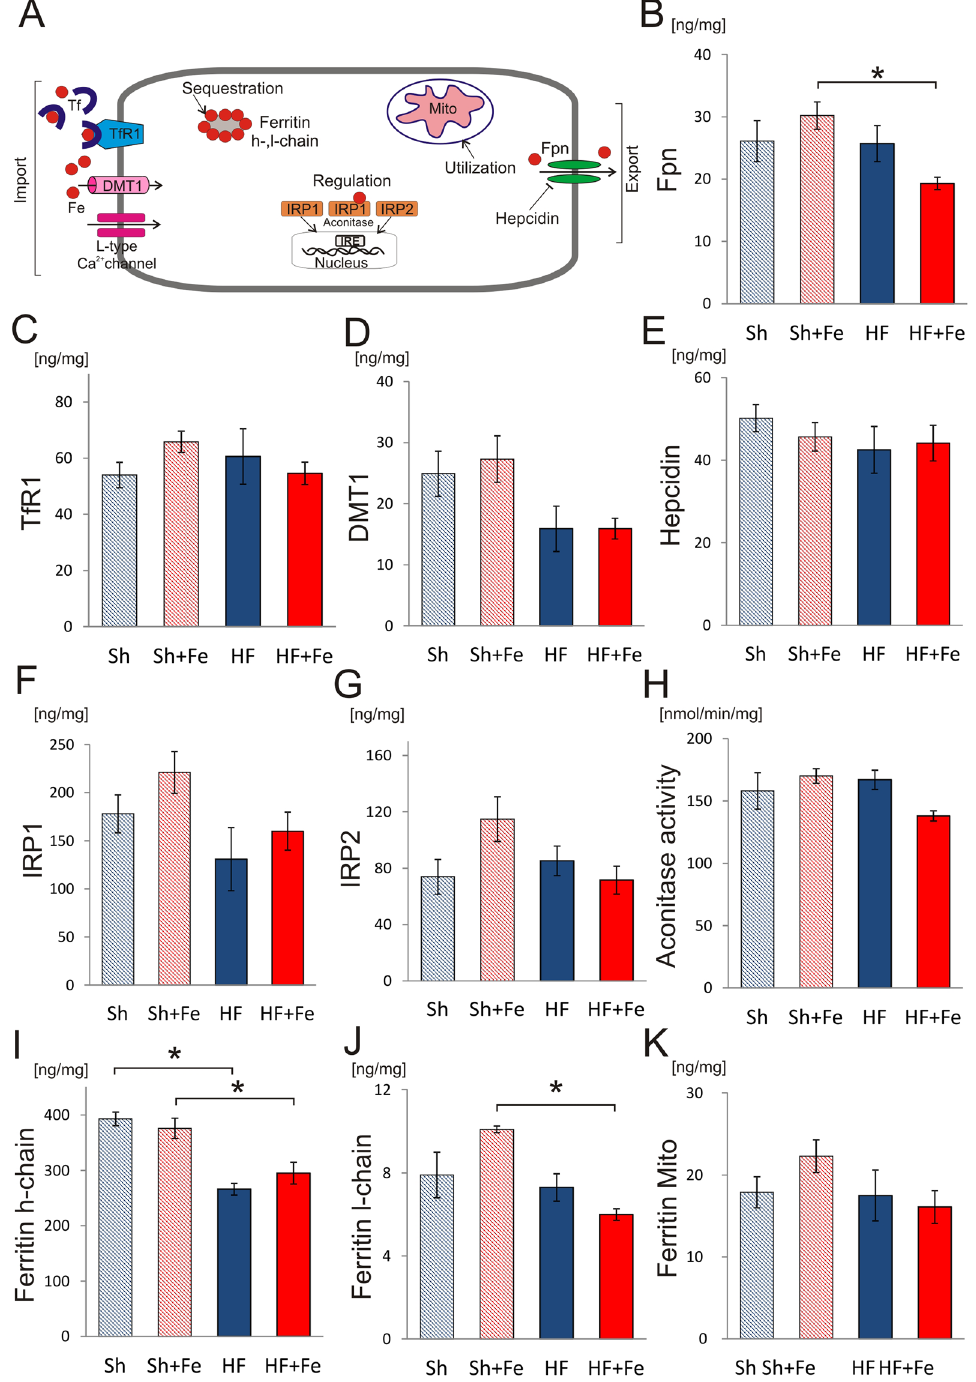
Figure 4. The effect of intravenous iron (Fe) supplementation on expression of the iron handling proteins in LV cardiac tissue from sham operated (Sh) and heart failure (HF) rats. ( A ) The schematic illustration of iron handling in cardiomyocytes. ( B – G ) Expression of ferroportin (Fpn), transferrin receptor 1 (TfR1), divalent metal transporter 1 (DMT1), hepcidin, iron regulatory protein 1 (IRP1) and iron regulatory protein 2 (IRP2), respectively. ( H ) Activity of aconitase - iron regulatory protein 1 (IRP1) containing [4Fe-4S] cluster. Expression of ferritin h-chain ( I ), l-chain ( J ) and mitochondrial ferritin ( K ). Data is represented as mean ± SEM, n = 5–6 rats in each group, * p < 0.05, only statistically significant differences were